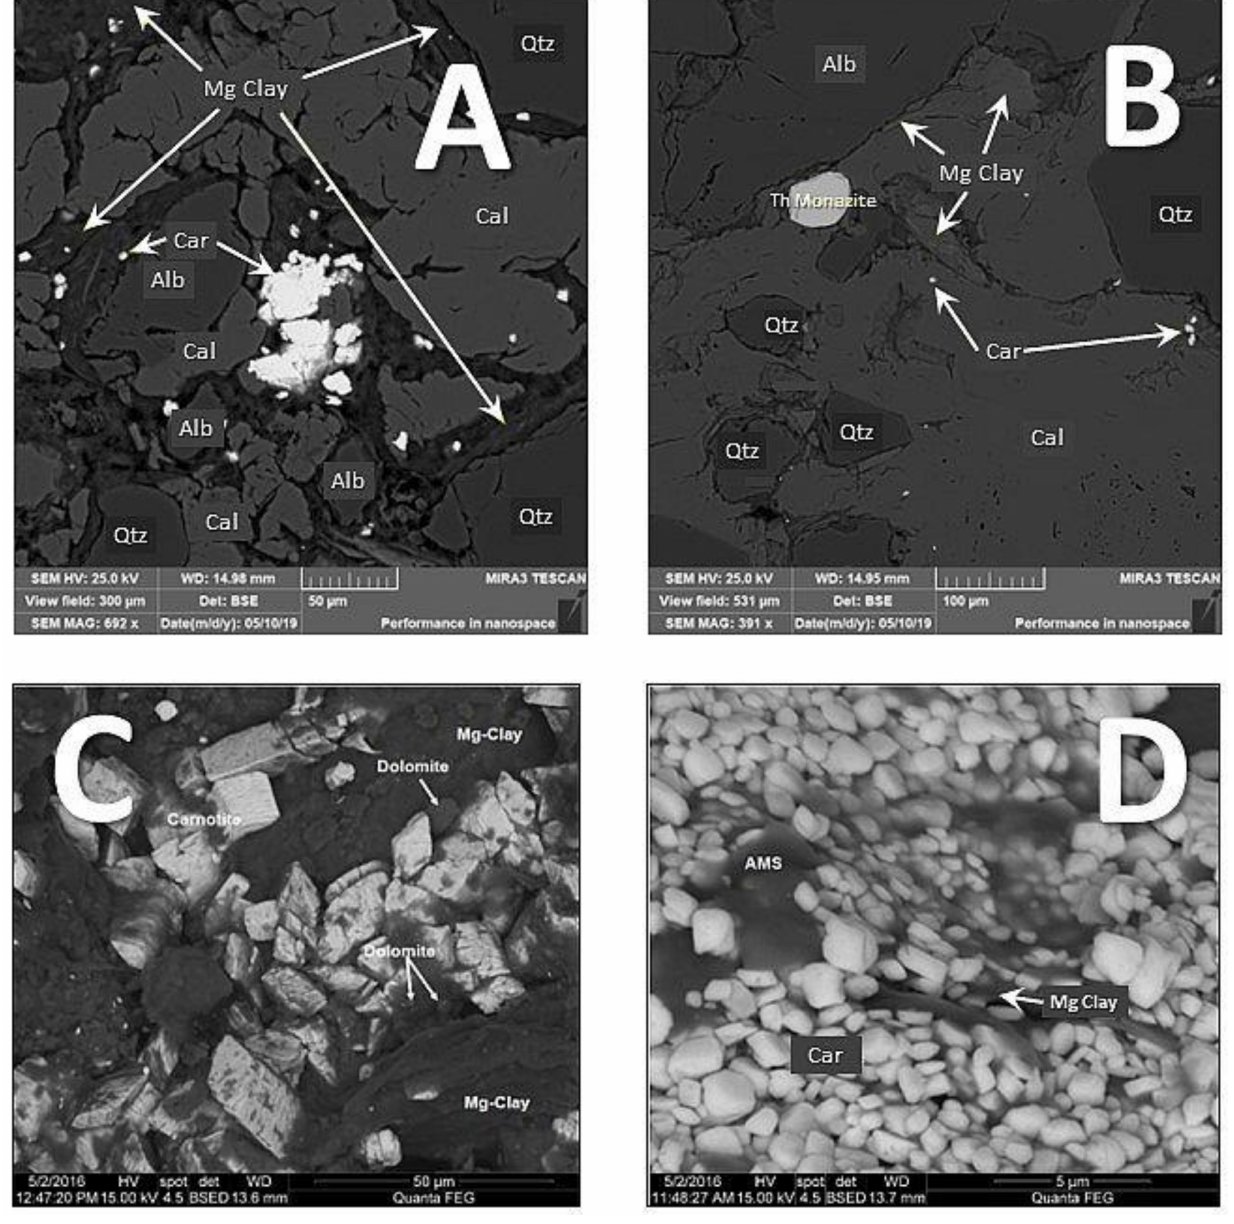
Figure 9. Back-scattered electron images showing the relationship of carnotite to detrital grains and cements. ( A , B ) Association of carnotite (light grey, Car) with authigenic Mg-Al silicates (Mg-Clay) and calcite (Cal). Detrital quartz (Qtz) fully enclosed in calcite cement. In addition, albite (Alb); Tumas. ( C , D ) Association of carnotite with dolomite, crystalline Mg silicate (Mg-Clay) and amorphous Mg silicate (AMS); Langer Heinrich